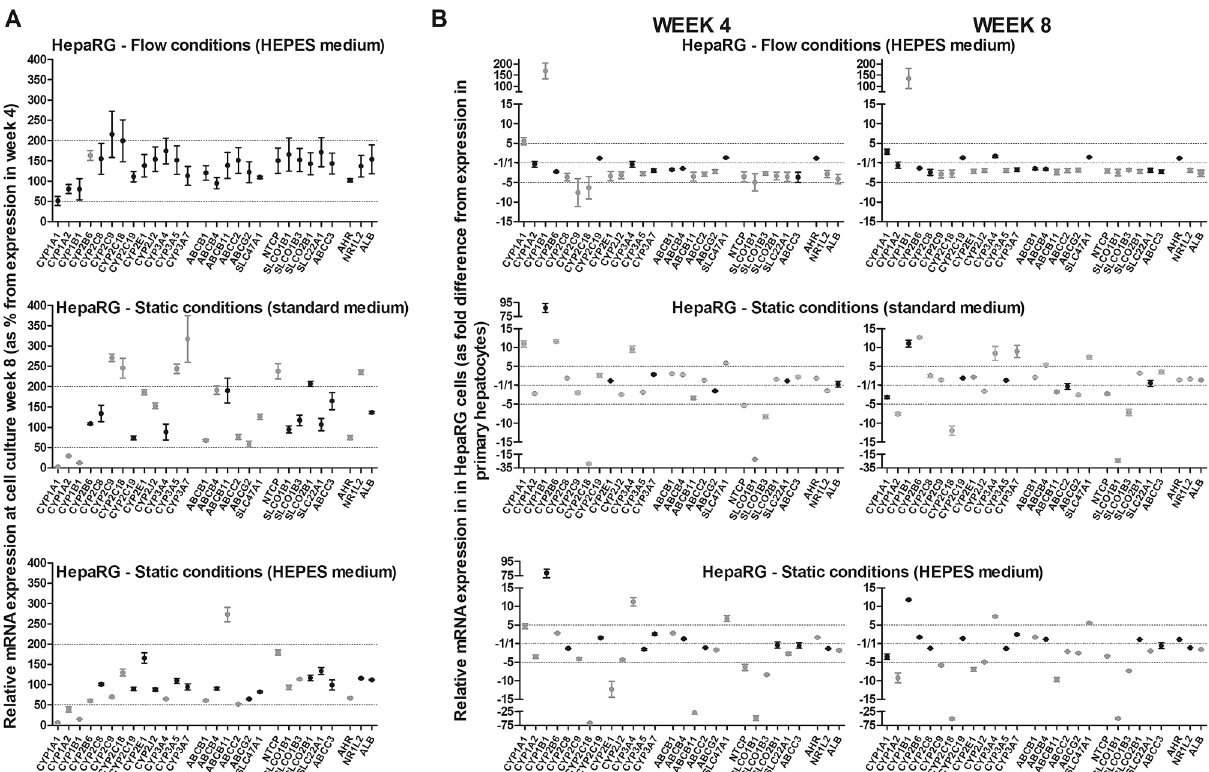
Figure 3. Stability of gene expression ( A ) of the selected genes over a period of 4 weeks of cells grown in the OOC-device (flow conditions) and in 24-well plates (static conditions). Expression at week 8 is given as a percentage of the expression at week 4 (mean ± SEM; n = 3). Symbols in grey are significantly different between week 4 and 8 (unpaired Student’s t-test; P < 0.05). Comparison of gene expression in HepaRG cells grown in the in primary hepatocytes (mean ± SEM; n = 3). Symbols in grey are significantly different between HepaRG cells and primary hepatocytes (One-way ANOVA and Bonferroni post-hoc; P <